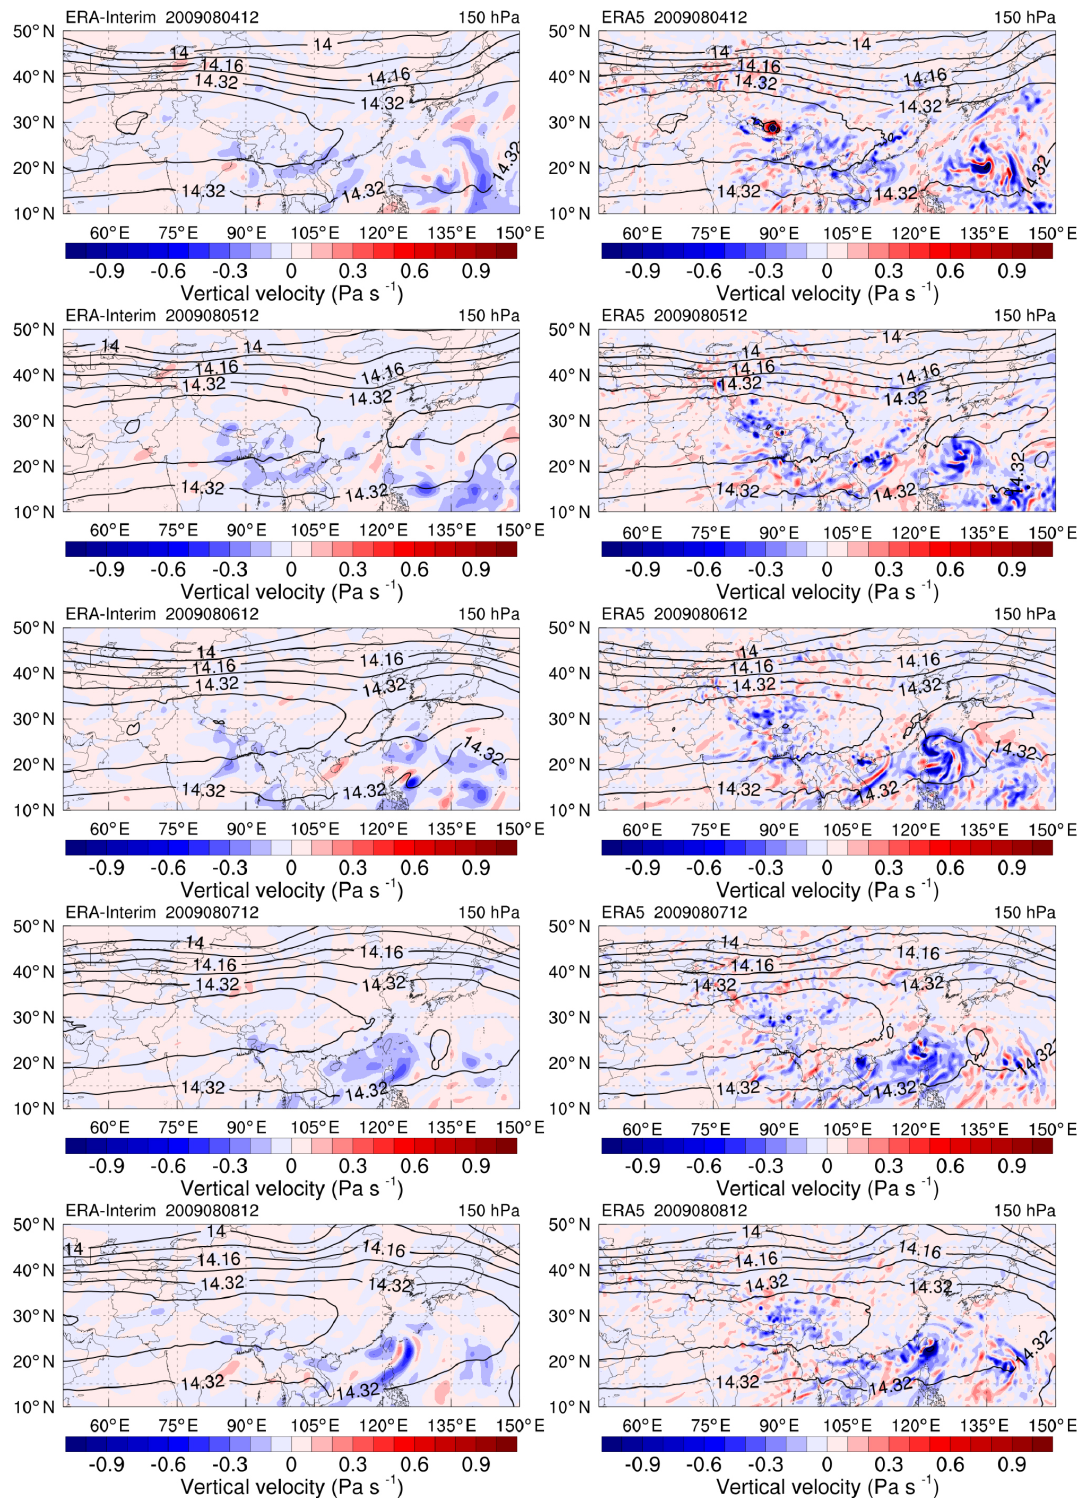
Figure 1. Geopotential height (black lines, gpkm) and vertical ω velocities (shaded, Pas − 1 ) at 150hPa on 4, 5, 6, 7, and 8 August 2009 from ERA-Interim (left) and ERA5